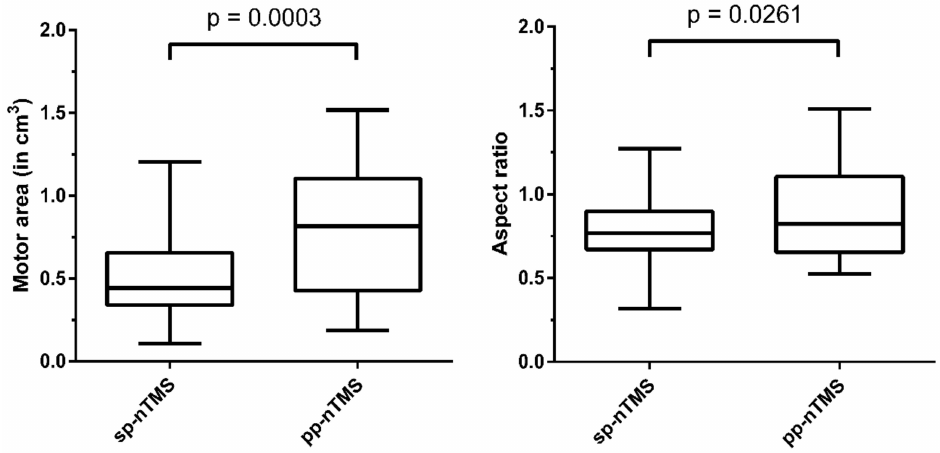
Figure 3. Volume of motor areas and aspect ratio. This figure with box plots including minimum to maximum whiskers shows the volume of the motor area (in cm 3 ) and aspect ratio as derived from motor mapping of the lower extremity (lE) muscle representations using single-pulse navigated transcranial magnetic stimulation (sp-nTMS) and paired-pulse nTMS (pp-nTMS).